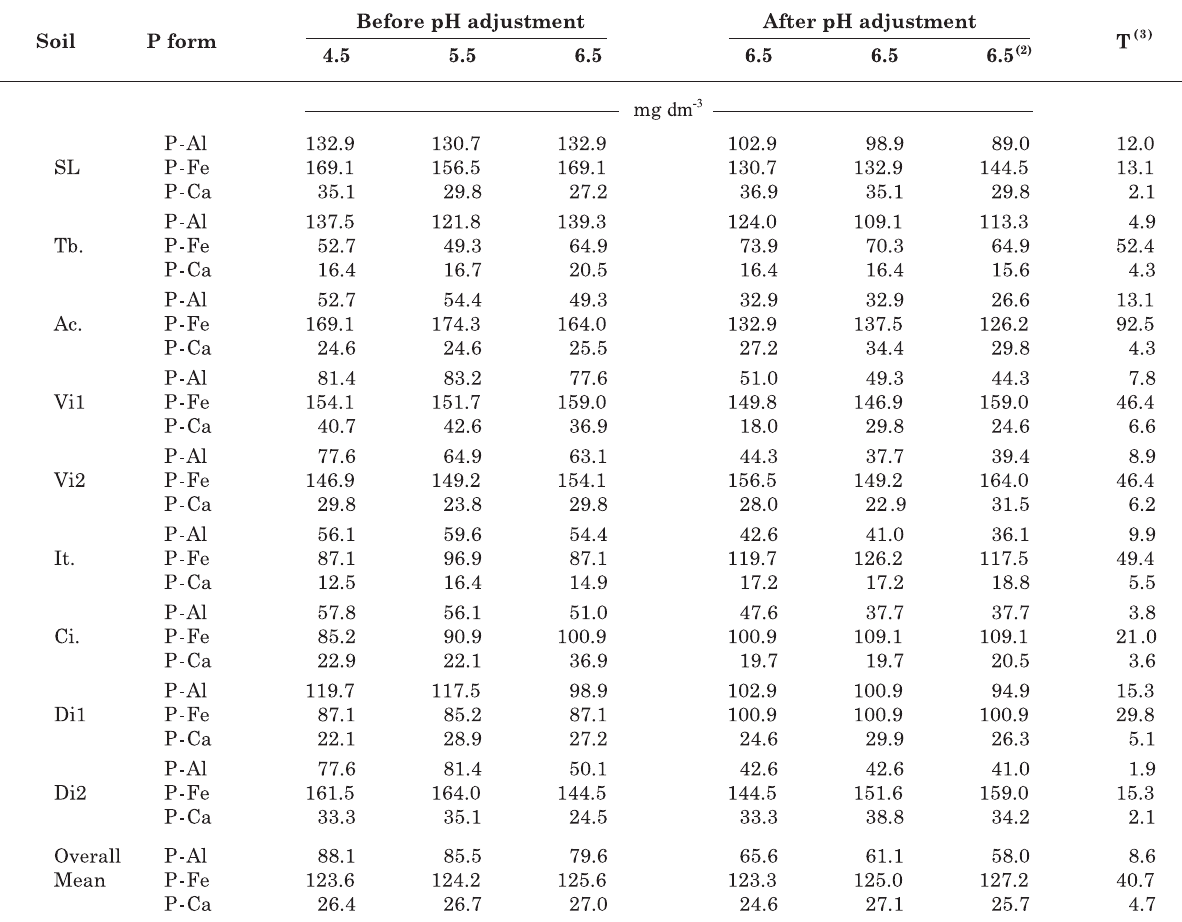
Table 7. Fractionation (1) of the inorganic P forms in soil as related to the pH (4.5; 5.5 and 6.5) and the application of 200 mg kg -1 of triple superphosphate in the samples studied before and after the second liming, to raise the pH of samples to